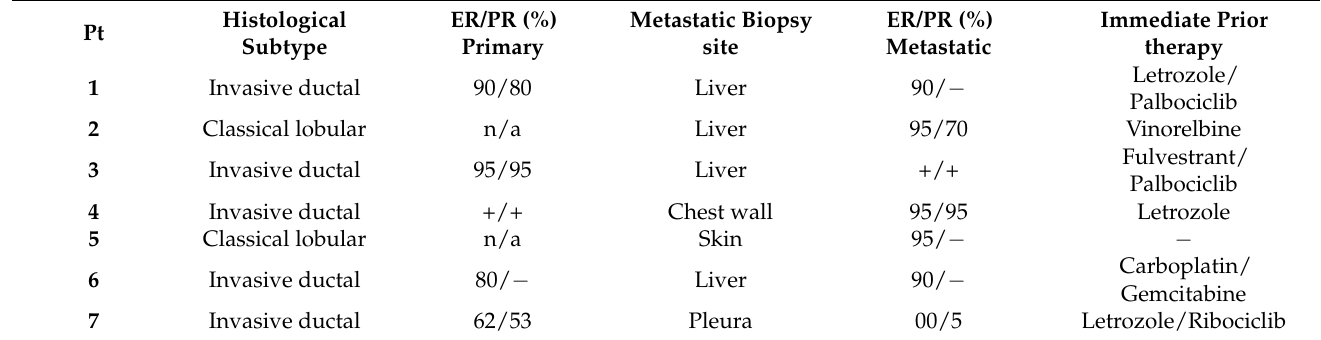
Table 2. Patient characteristics.